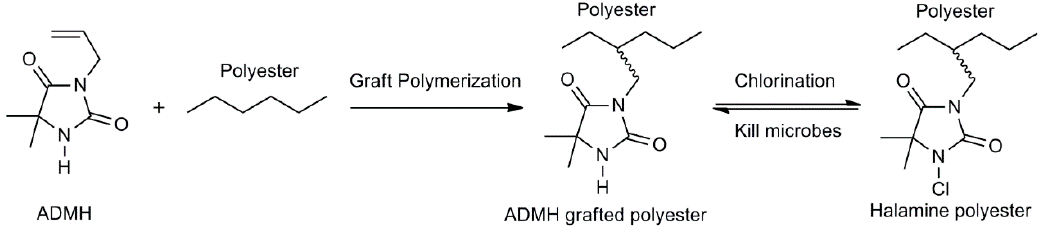
Figure 1. Scheme of grafting 3-allyl-5,5-dimethylhydantoin (ADMH) onto polyester, and chlorination and antibacterial function of the